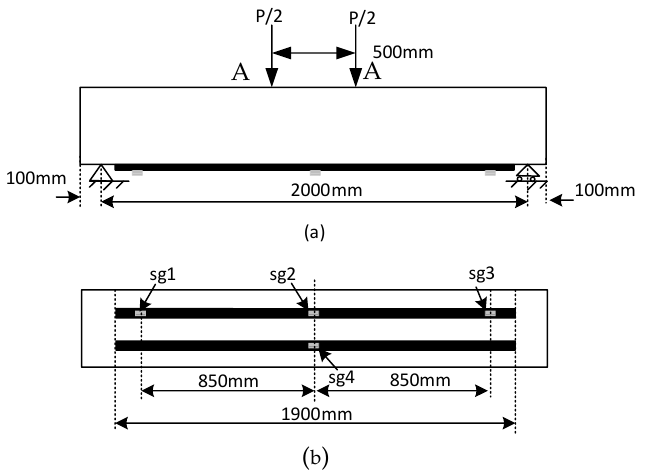
Figure 2. ( a ) Experimental set up ( b ) location of strain gauges on the bottom face of the beams.